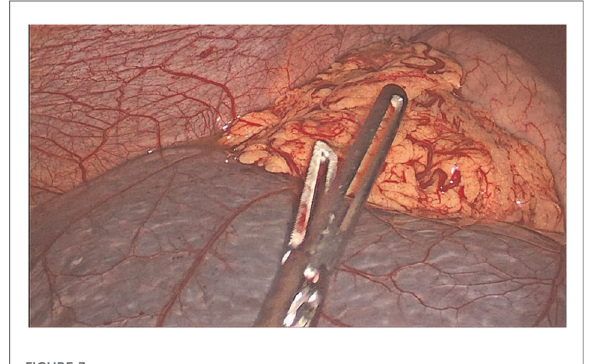
FIGURE 3 Intraoperative exploration of the spleen.